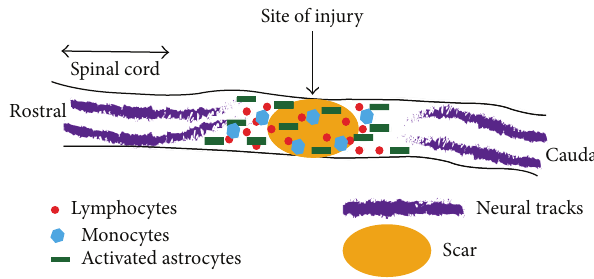
Figure 1: Mechanism of spinal cord